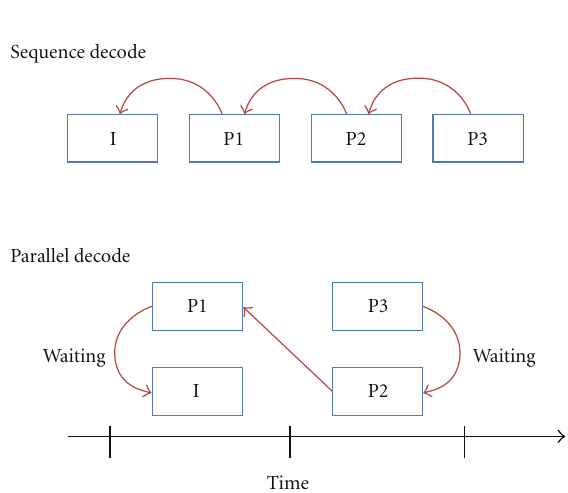
Figure 4: Sequence/Parallel Video Decode.